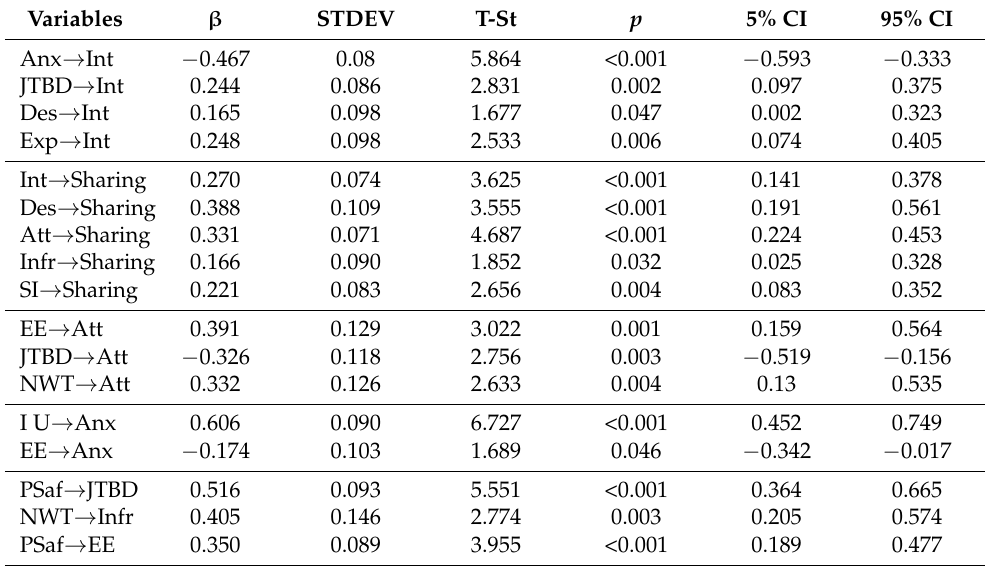
Table 5. Direct effects: path coefficients ( β ), standard deviation (STDEV), T Statistics (T-St), p Values, 5% and 95% confidence intervals